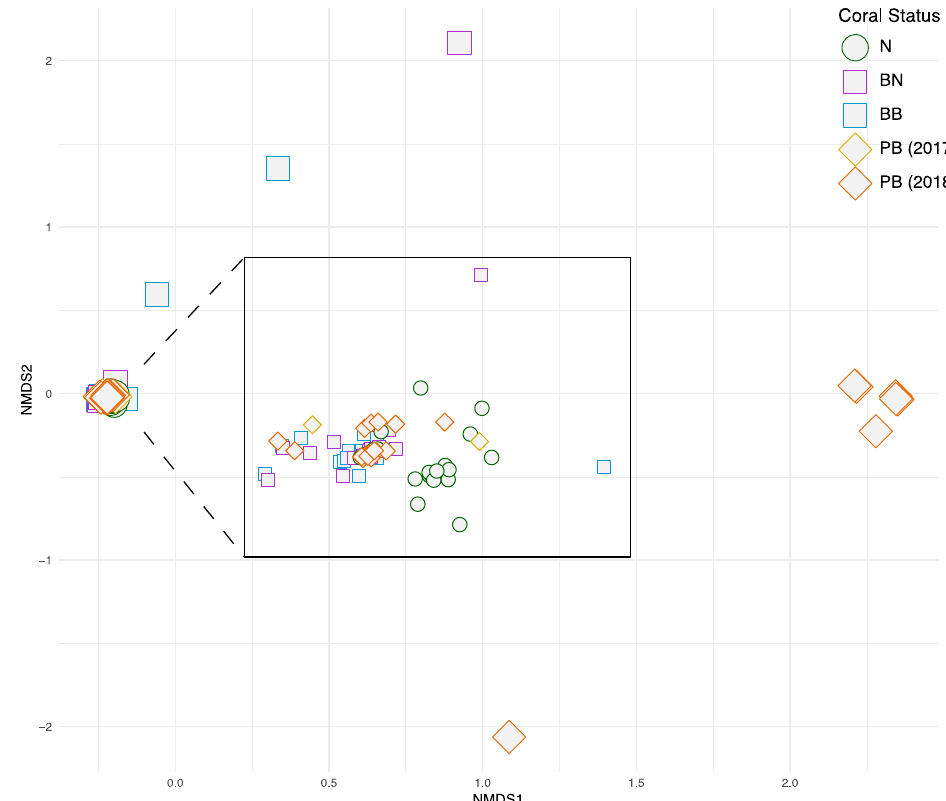
Figure 6. Non-metric multidimensional scaling (NMDS) based on proportional abundances of Symbiodiniaceae types with each point representing a coral sample (N: normal colonies in 2016, BN: normal portions of the bleached colonies in 2016, BB: bleached portions of the bleached colonies in 2016, PB (2017): post-bleaching colonies in 2017, PB (2018): post-bleaching colonies in 2018). Inset shows expanded main cluster.